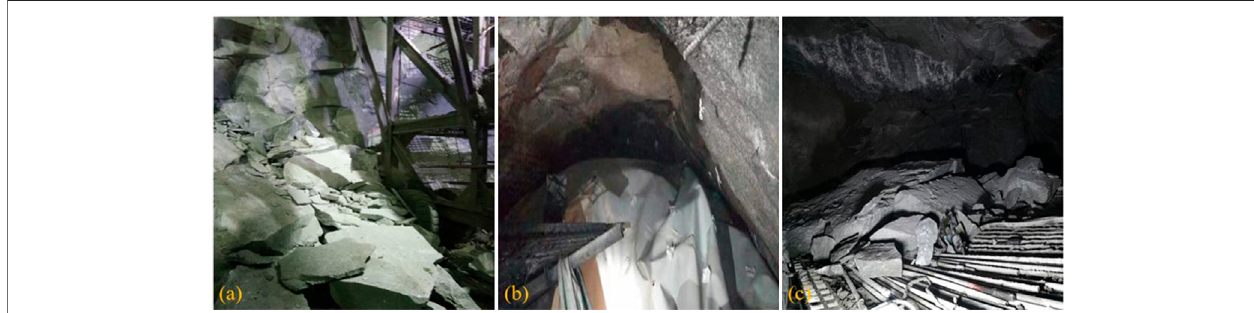
FIGURE 1 | Rockburst disasters occurred at Paoma mountain No. 1 tunnel.